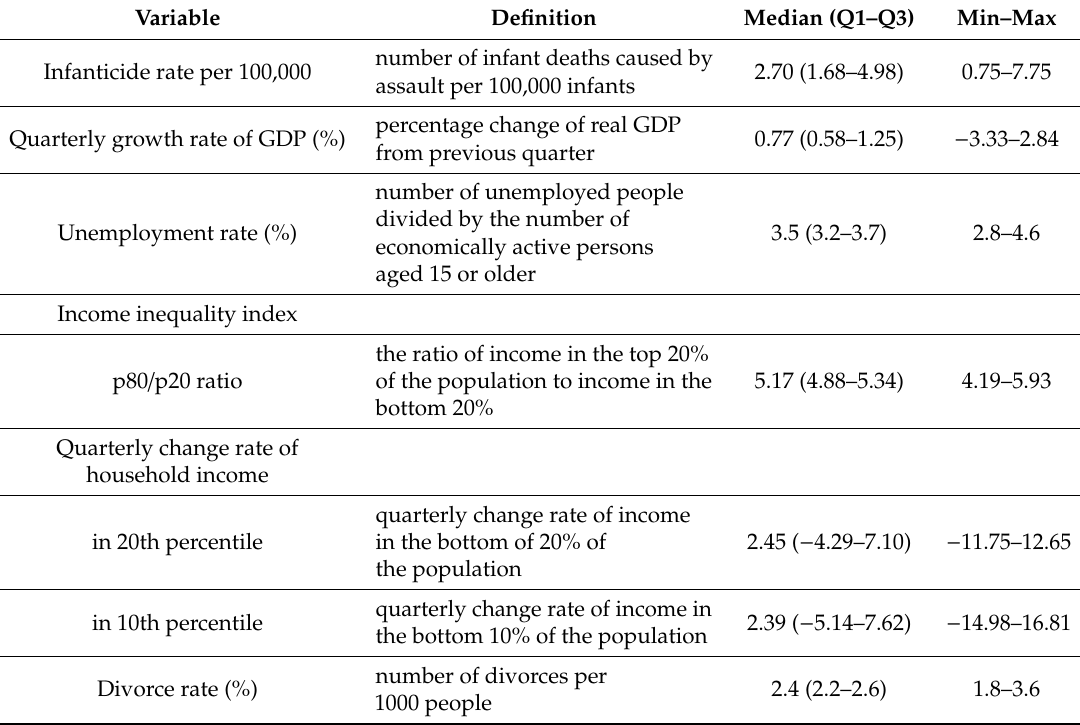
Table 1. Definitions and characteristics of socioeconomic